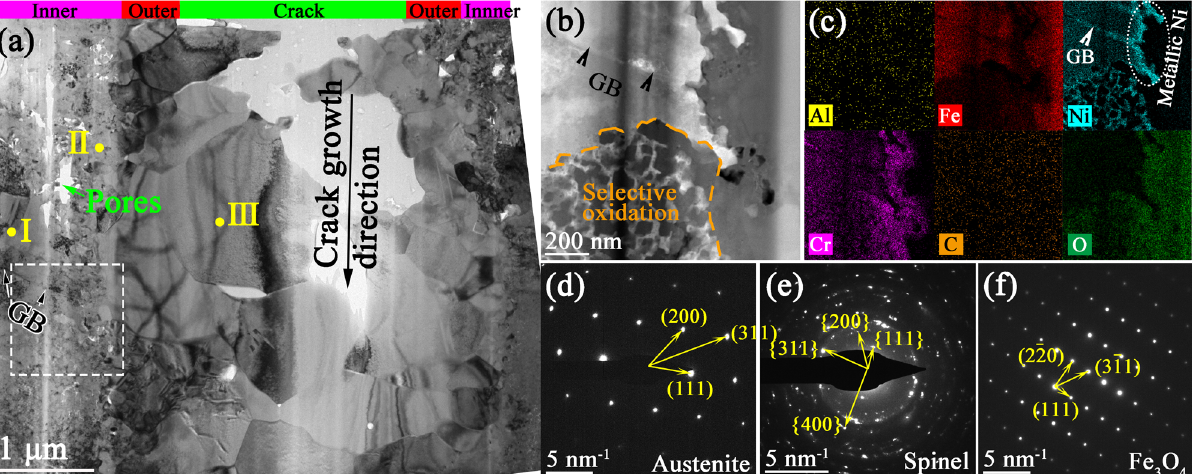
Fig. 11 TEM results near the crack tip of A0 sample (0Al – 0.6Nb). a BF image, b HAADF image inside the white frame, c EDS mapping of ( b ), d – f SAED patterns of I, II and III regions labeled in ( a